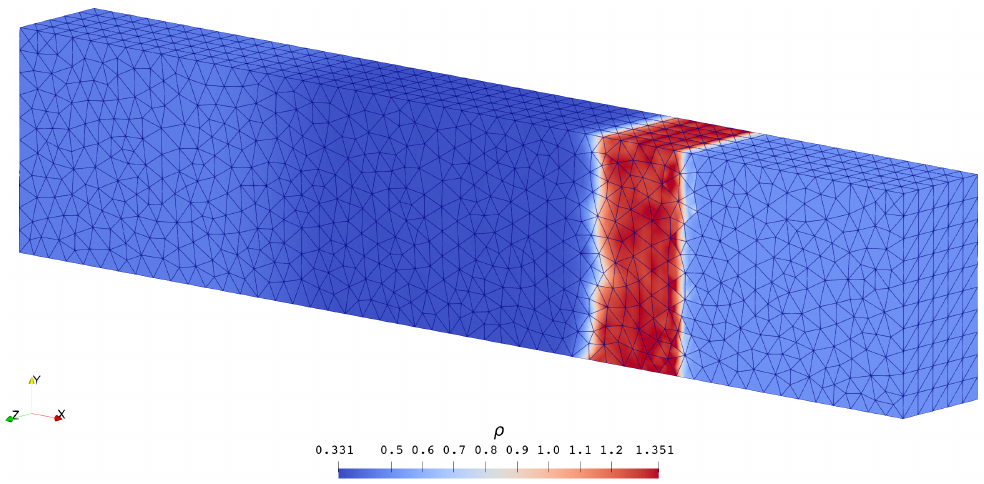
Figure 4. Third-order solution of ρ ( t = 0.5 ) in Problem